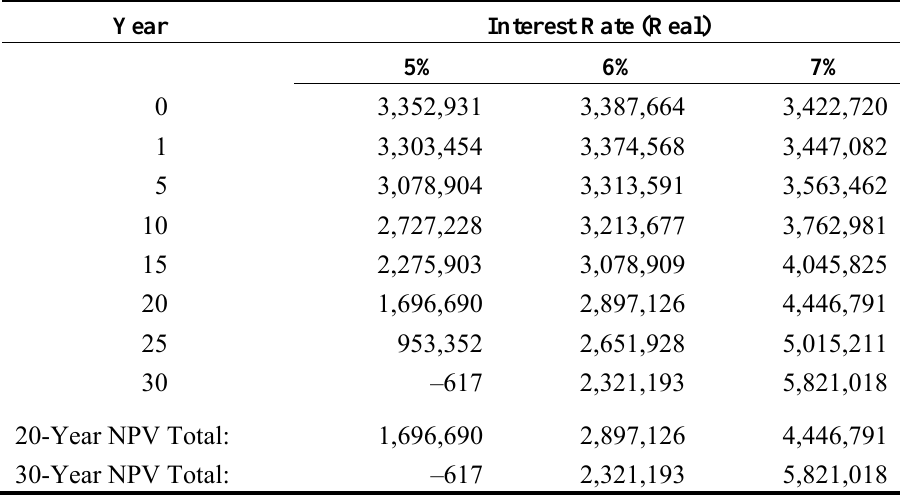
Table 4. The annual results of the BAU